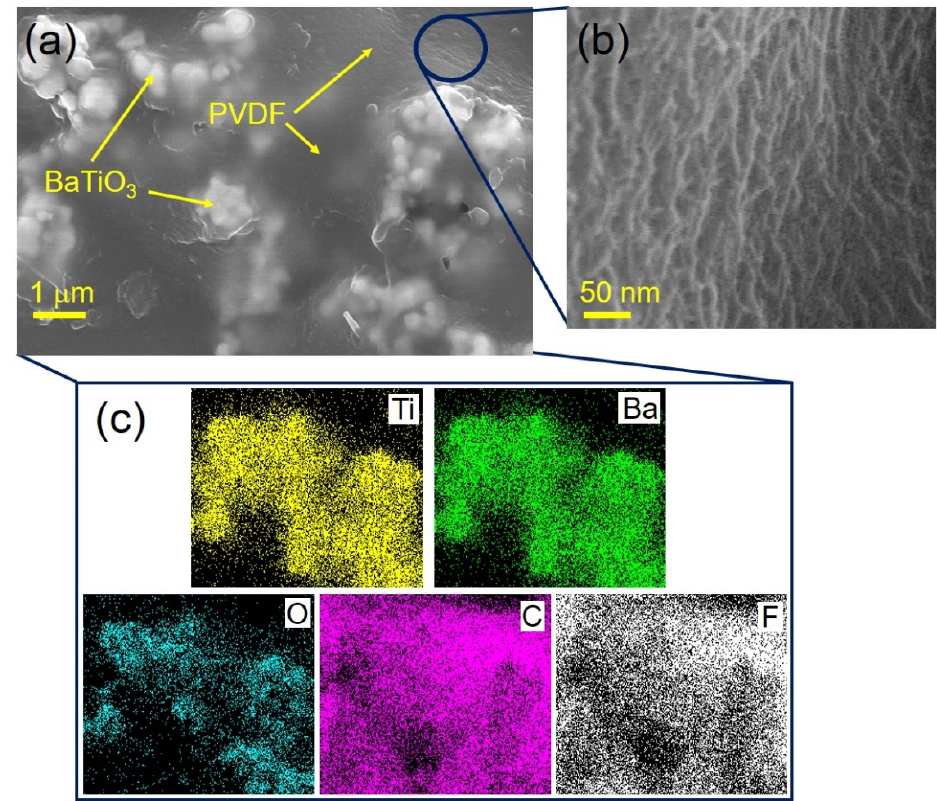
Figure 2. ( a ) FESEM micrograph of the as-prepared PBC film; ( b ) enlarged view of PVDF surface; ( c ) corresponding elemental mapping of the PBC film.